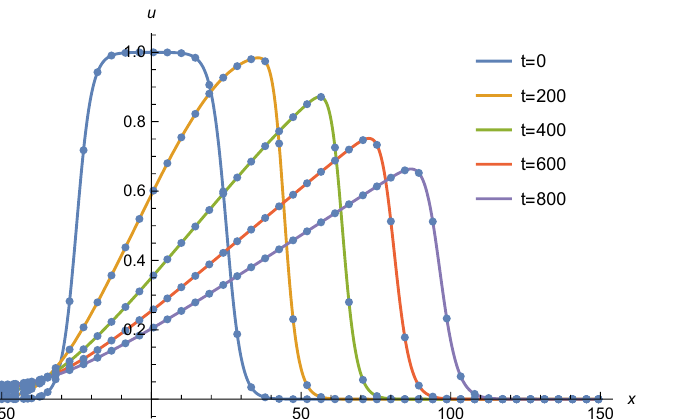
Figure 12. Comparison of OCFE solution (dots) and Mathematica built-in solver (solid line) at different times.